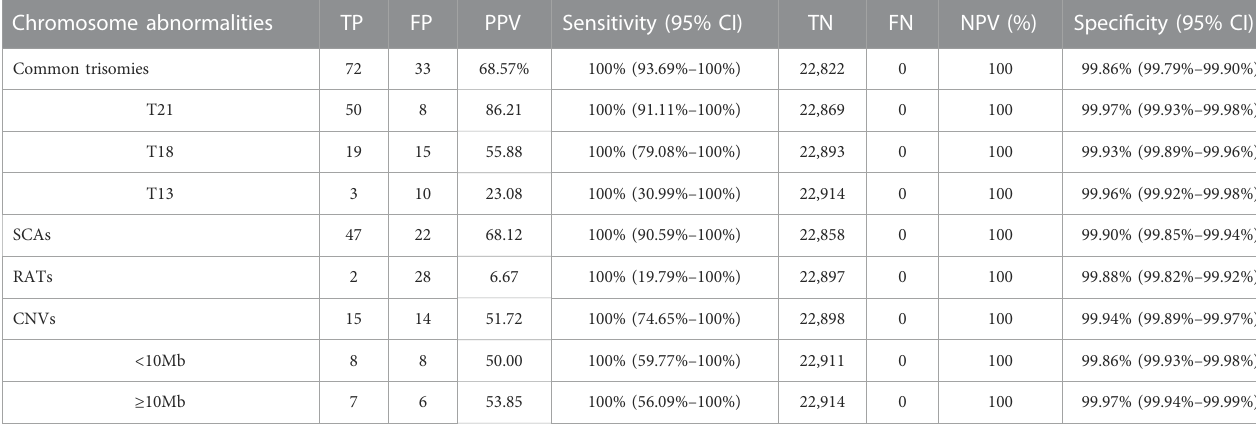
TABLE 2 The performance of NIPT-Plus in screening for chromosome aneuploidy and copy number variations. Chromosome